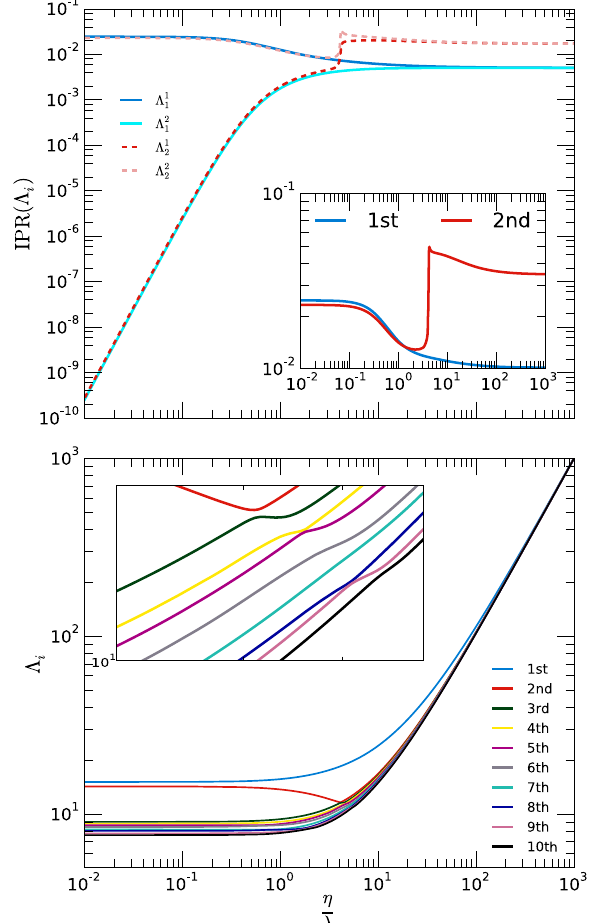
FIG. 11. Spectral properties of the tensor R ð λ ; η Þ as a function of the ratio η = λ for a multiplex with two layers with the same degree distribution (different random realizations of the configu- ration model) and connected to its counterpart on the other layer. In the top panel, we present the inverse participation ratio of the two larger eigenvalues and the individual-layer contributions, while in the bottom panel, we show the leading eigenvalues. Every curve is composed of 10 3 log spaced points, in order to have enough